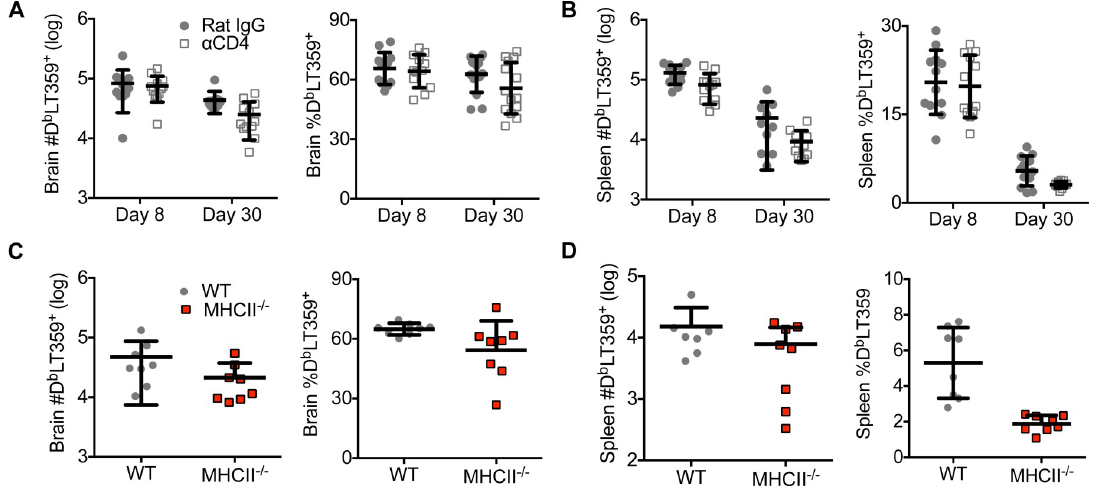
Fig 1. Brain and spleen MuPyV-specific CD8 T cell responses in CD4 T cell-sufficient and—deficient mice. (A, B) Number (left) and frequency (right) of CD44 hi D b LT359 tetramer + CD8 T cells in brain (A) and spleen (B) during acute (day 8 p.i.) and persistent (day 30 p.i.) infection. (C, D) Number (left) and frequency (right) of CD8 + CD44 hi D b LT359 tetramer + in brain (C) and spleen (D) during persistent (day 30 p.i.) infection in WT and MHCII -/- mice. Mean ± SD of 7–10 mice per group from 2 independent